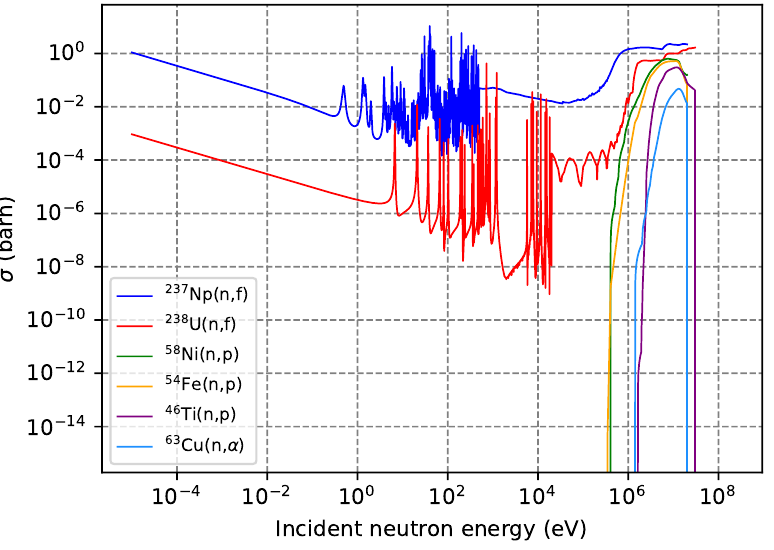
Figure 3. Activation cross sections taken from the JEFF-3.3 library and processed at 600